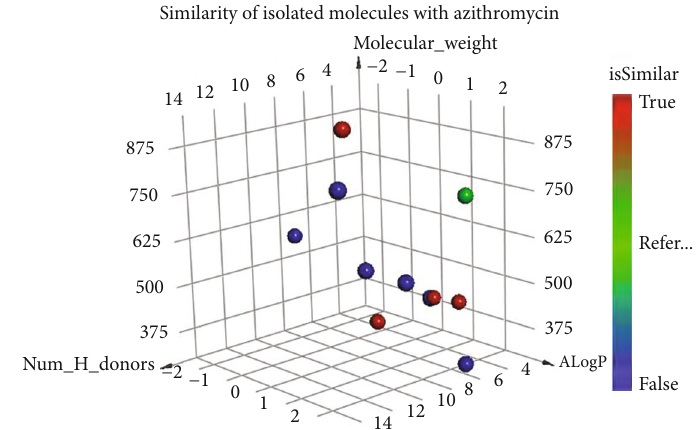
Figure 21: The similarity analysis between the tested molecules and (Azithromycin). Green ball=(reference); red balls =similar ligands; blue balls =not similar